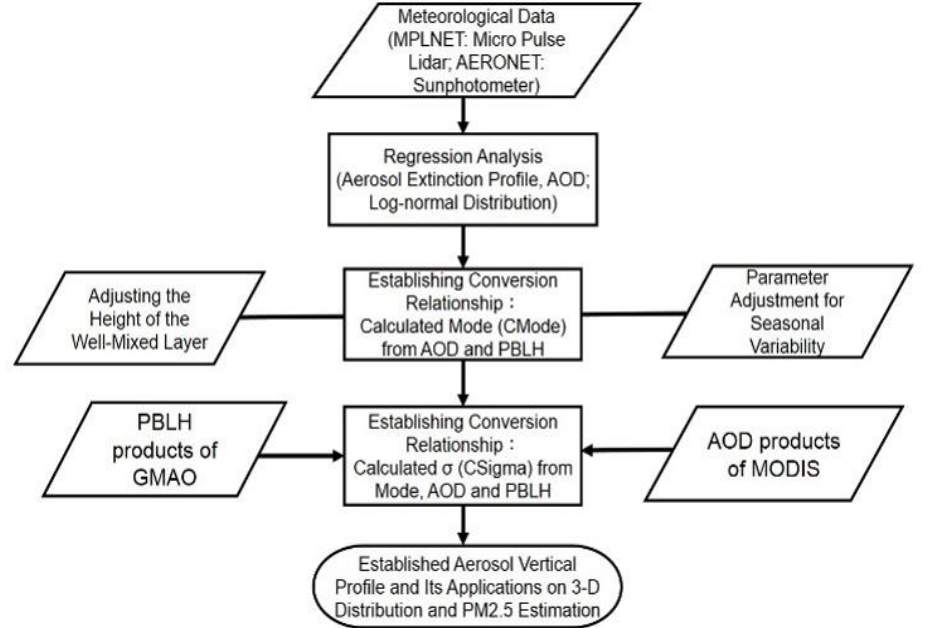
Figure 2. Flow chart of the regression analysis and profile fitting model construction used in this study.